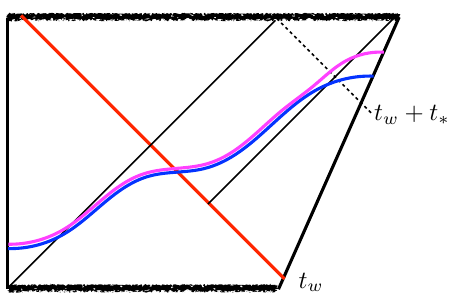
Figure 3 . Maximal volume slices after scrambling